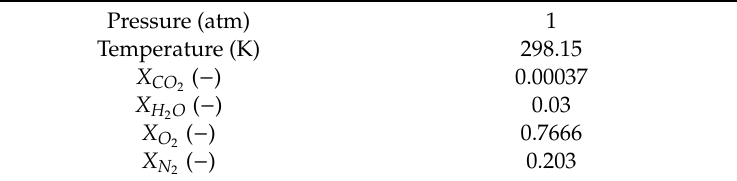
Table 1. Thermodynamic state and composition of the environment